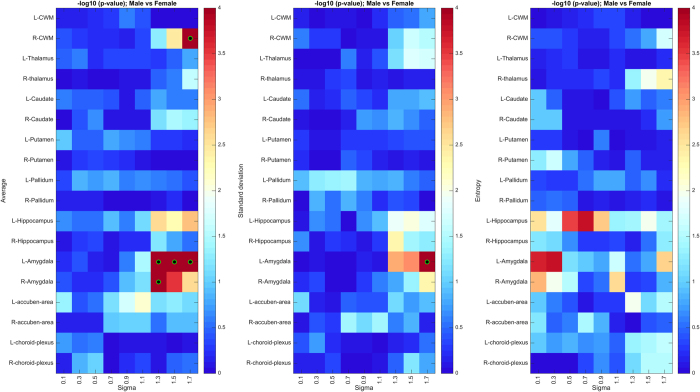
Significance of male vs female (p-values, −log10 scale) in selected regions, for various filter scales (sigma).Green-black circles indicate region-scale values with significant p-values following Holm-Bonferroni correction.